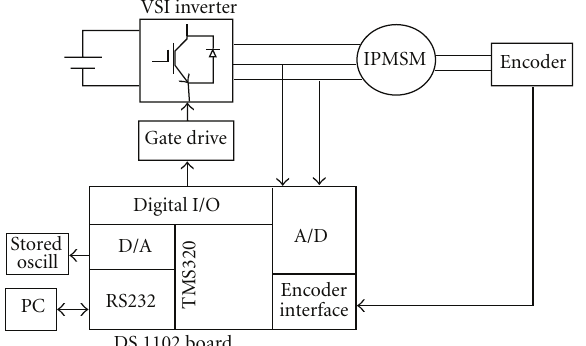
Table 2: Machine